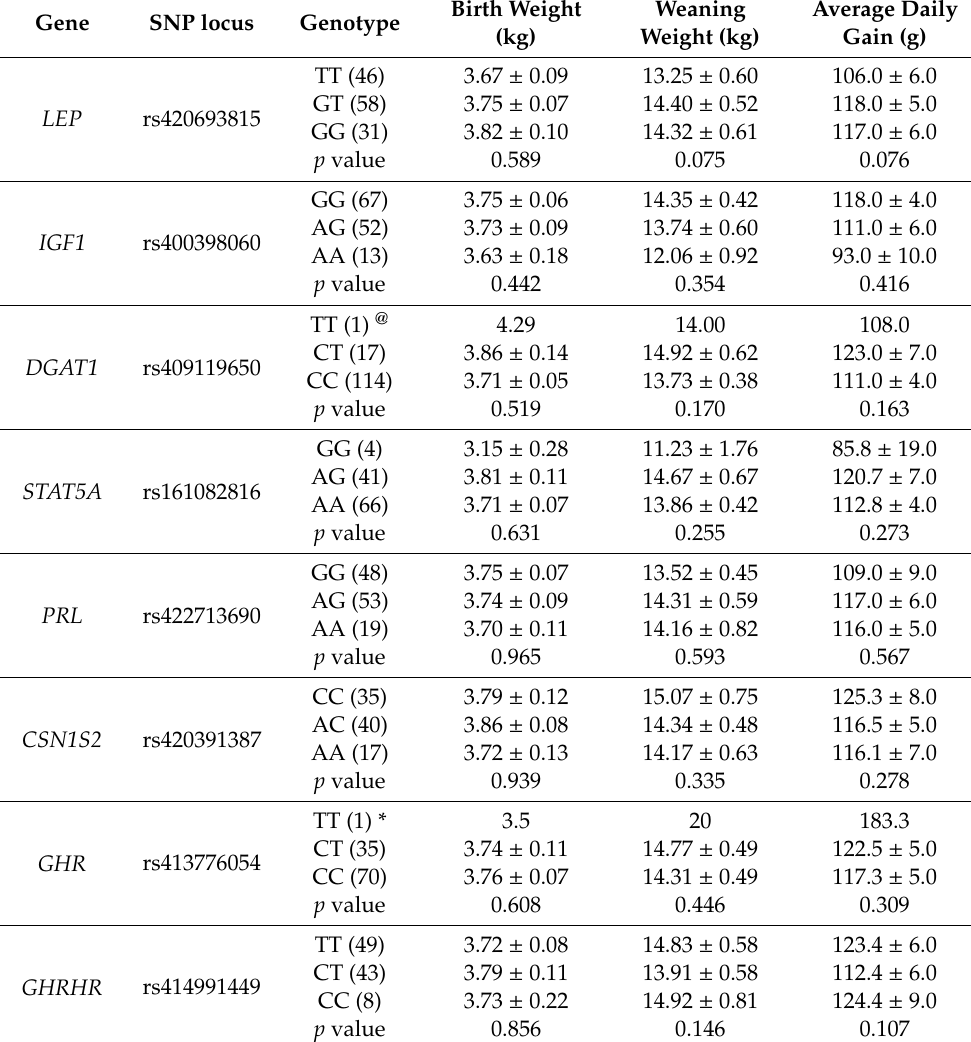
Table 7. Association of SNPs of studied genes with growth traits in Barki lambs (Mean ±